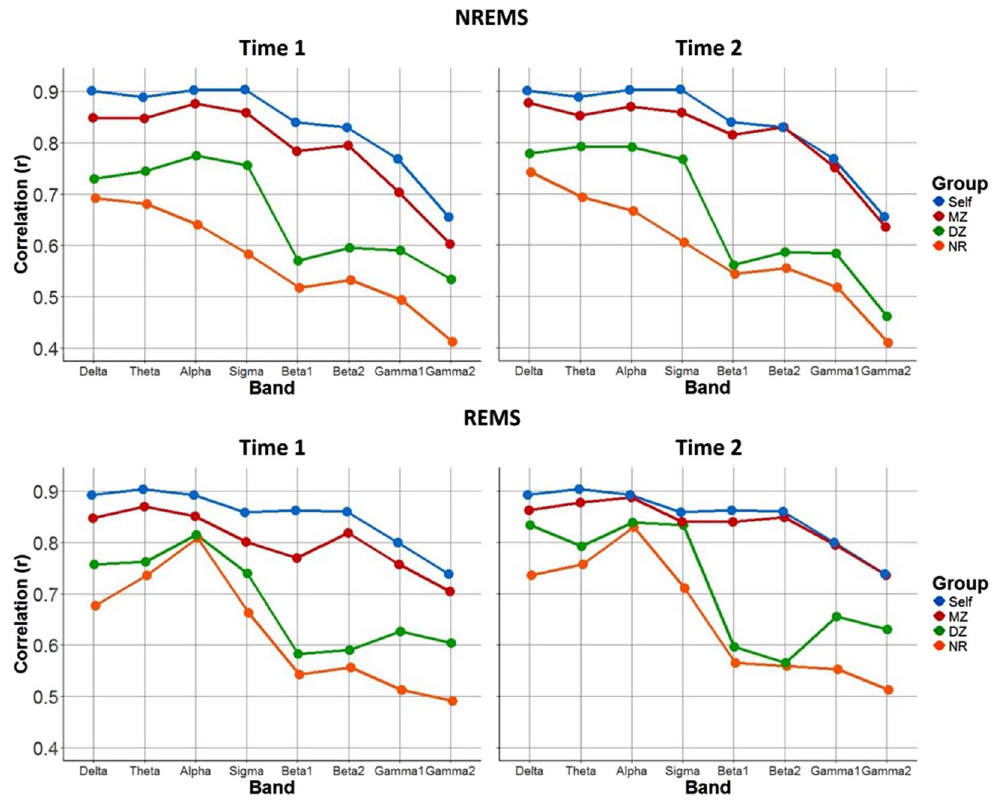
Figure 1. Correlation coefficients averaged for the four groups. Self = two time points in one individual separated by 6 months; MZ = monozygotic twins, DZ = dizygotic twins, NR = non-related individuals. Note that the same data from the Self group is shown in both time 1 and time 2 plots since this measure uses both assessment points. Sample size varied by group (Self n = 50; MZ n = 14; DZ n = 11; NR n =